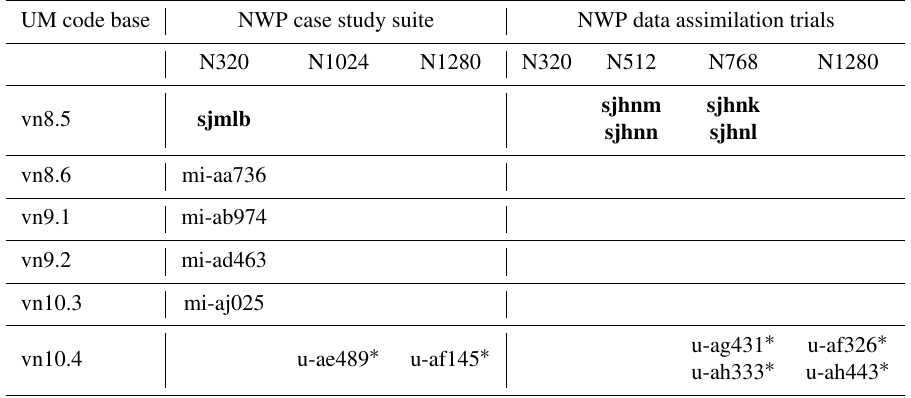
Table 7. Identifiers for a set of GA6.1/GL6.1 reference simulations across a number of UM code versions and systems/applications. Identifiers follow the same conventions outlined in Table 6. Suites with identifiers marked with a ∗ also include the fixes to the model orography and reduced solver tolerance discussed in Sect. 5.4.1 and